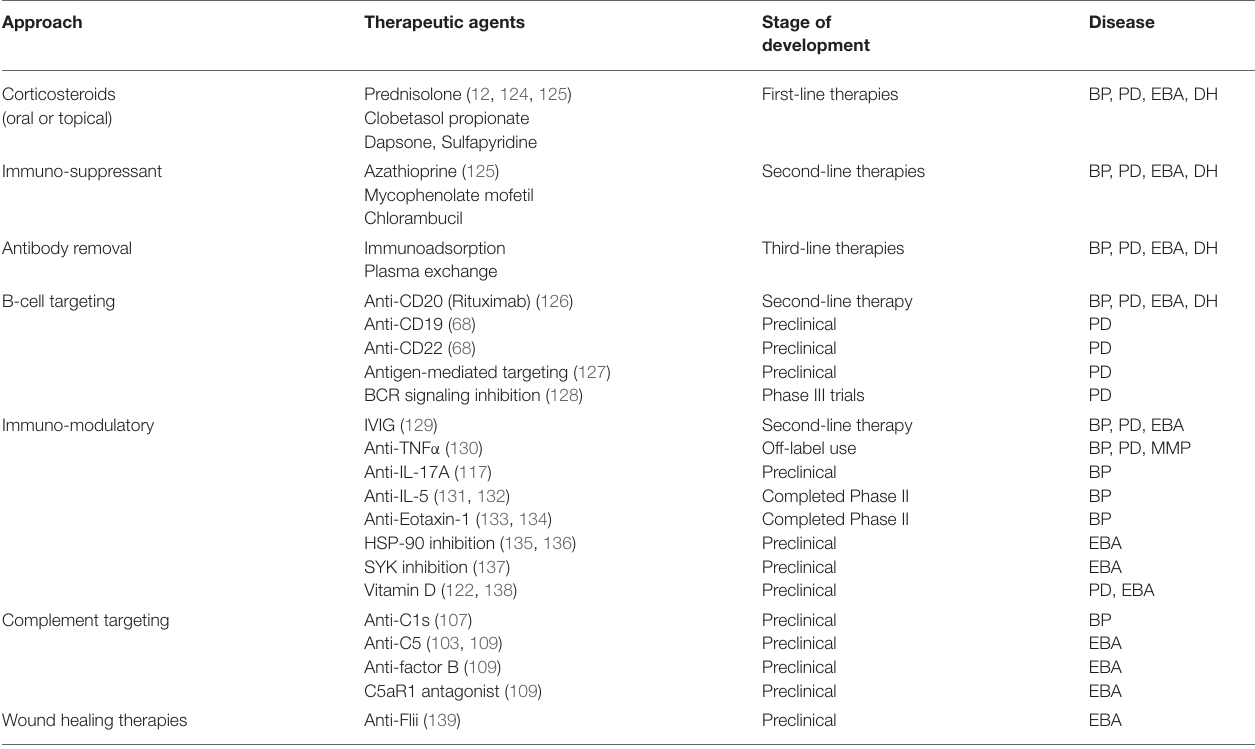
TABLE 1 | Current and emerging therapeutic approaches in autoimmune skin blistering diseases.